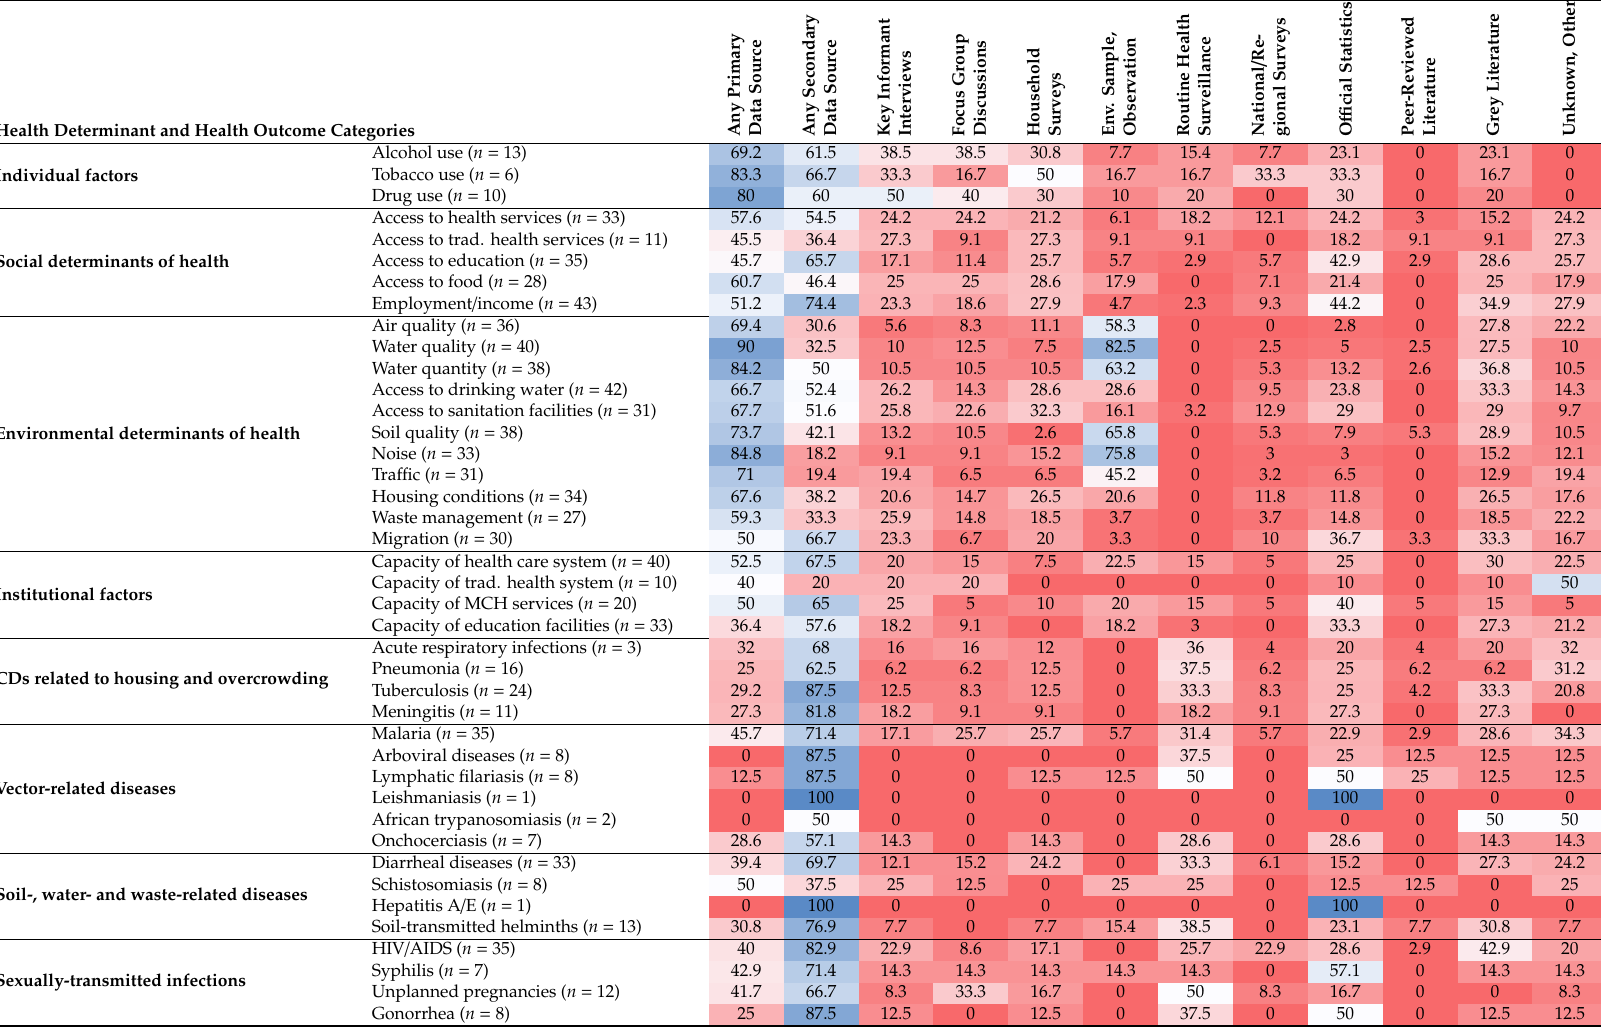
Table A5. Data sources for health determinants and health outcomes used for measuring baseline conditions in impact assessment